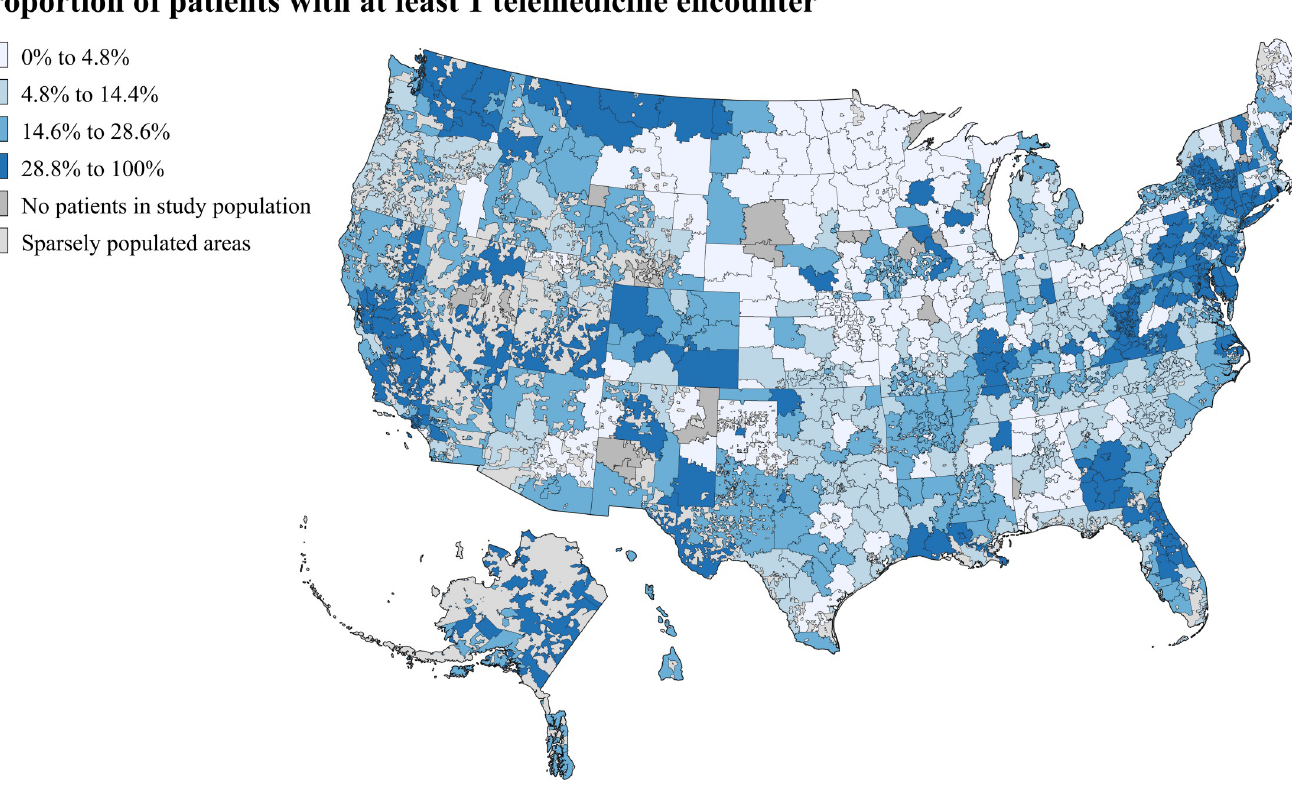
PLOS ONE | https://doi.org/10.1371/journal.pone.0269535 June 29,